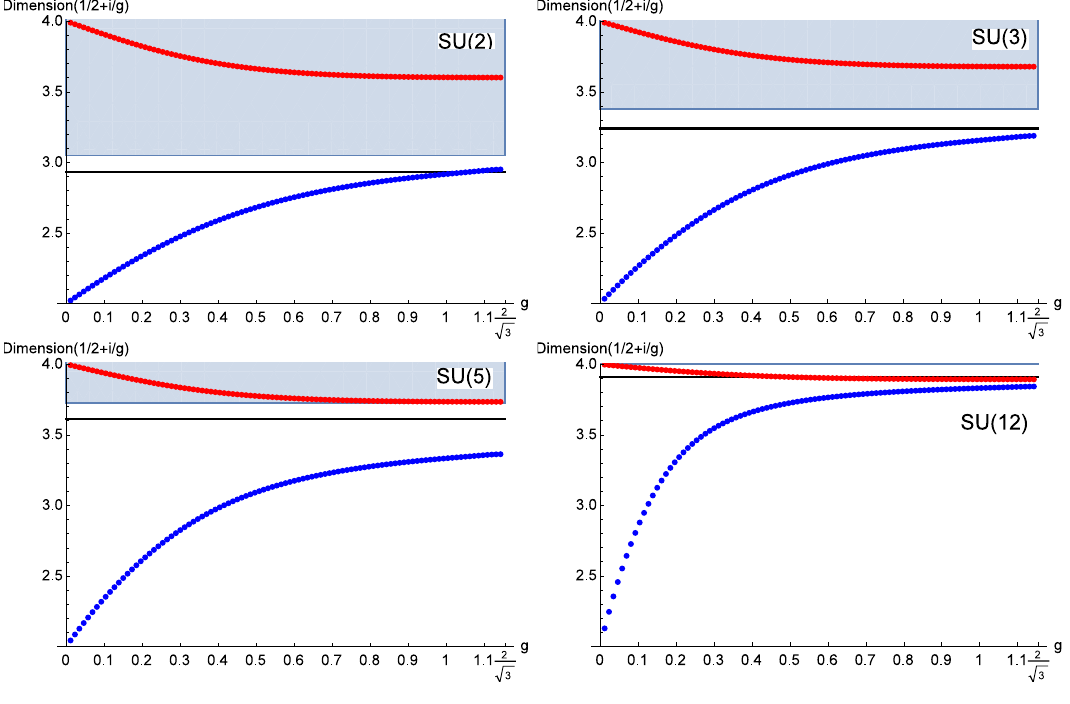
Figure 16 . Similar plots for (cid:18) = (cid:25) as (cid:12)gure 15.